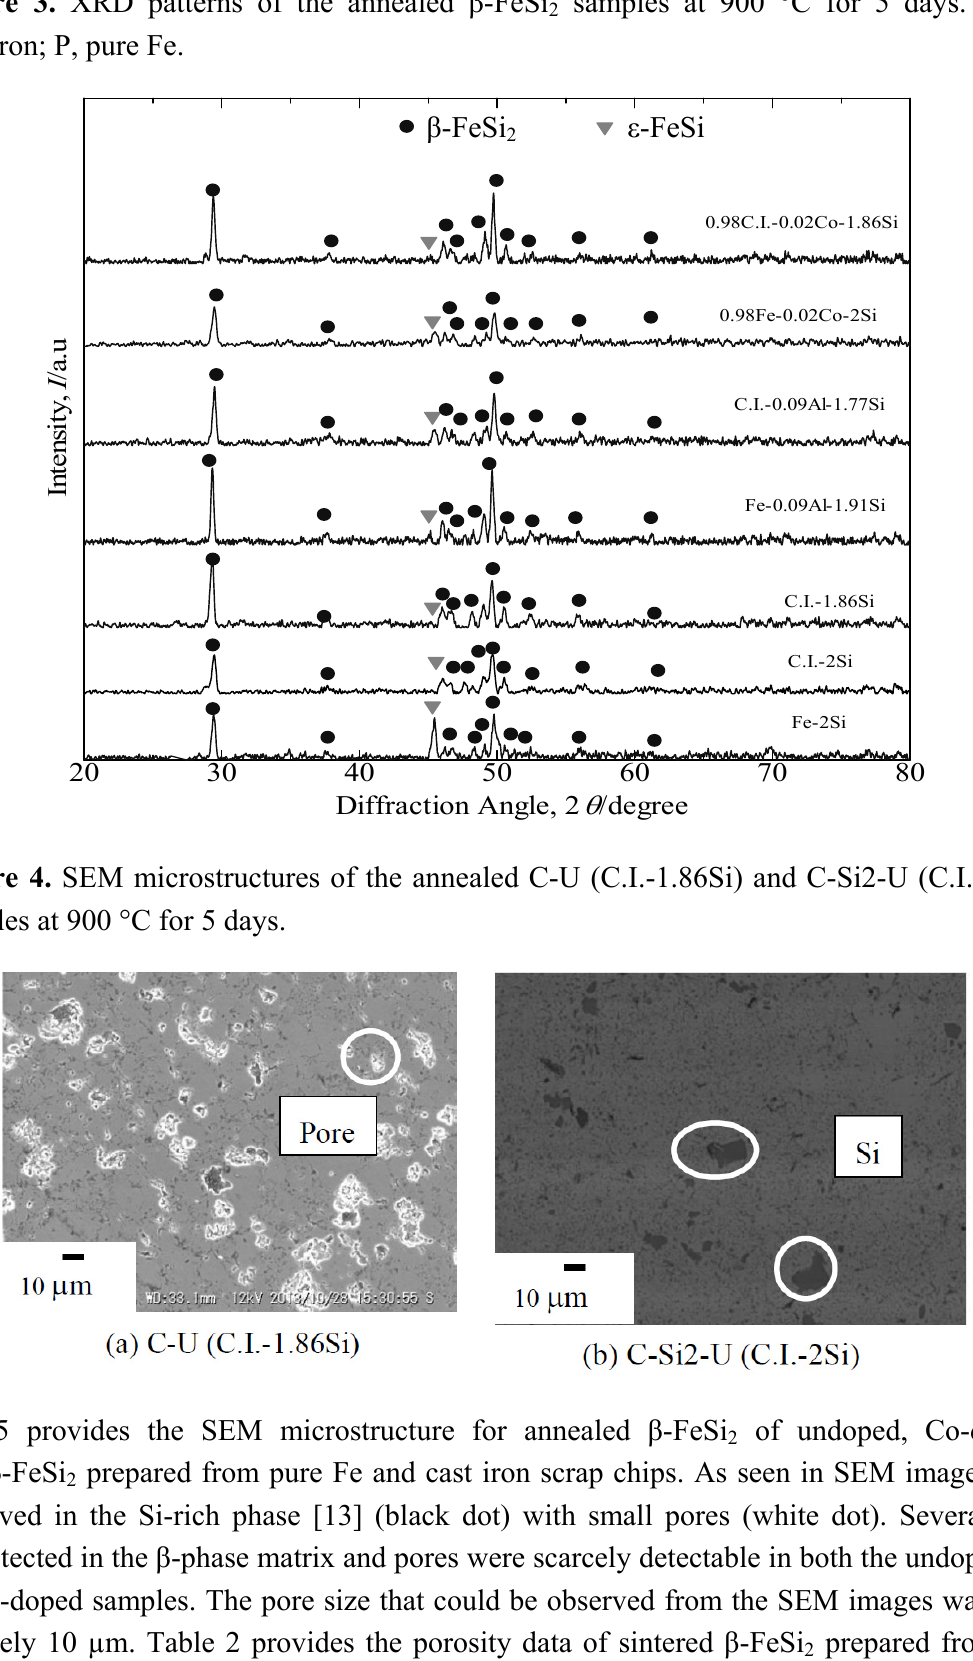
samples at 900 °C for 5 days. C.I., 2